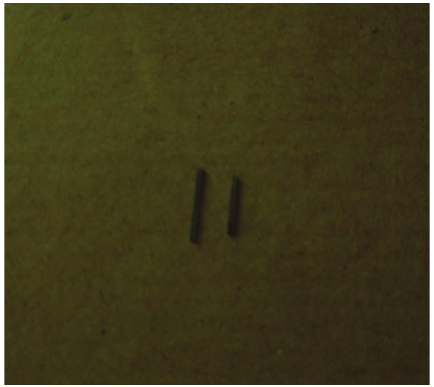
Figure 8: Fragments of the broken